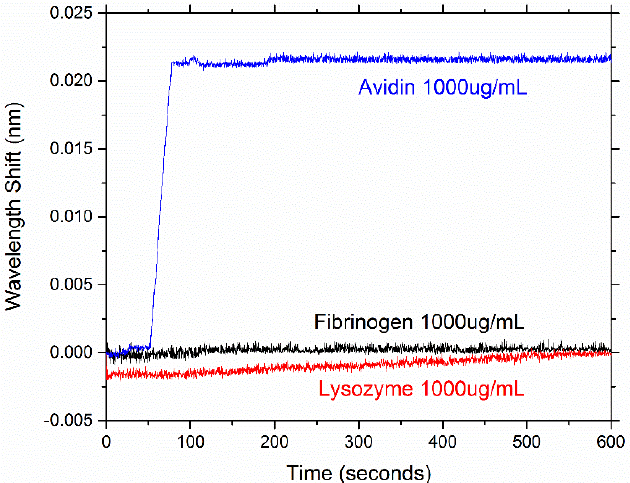
Figure 14. A representative example of the resonant wavelength shift of one of the PEG-biotin:PEG coated microresonators used in the study for different concentrations of fibrinogen, lysozyme, and biotin at the concentration of 1000 μ g/mL. Fibrinogen and lysozyme show a minimal response, while avidin has a clearly defined wavelength shift that is approximately 20 pm.